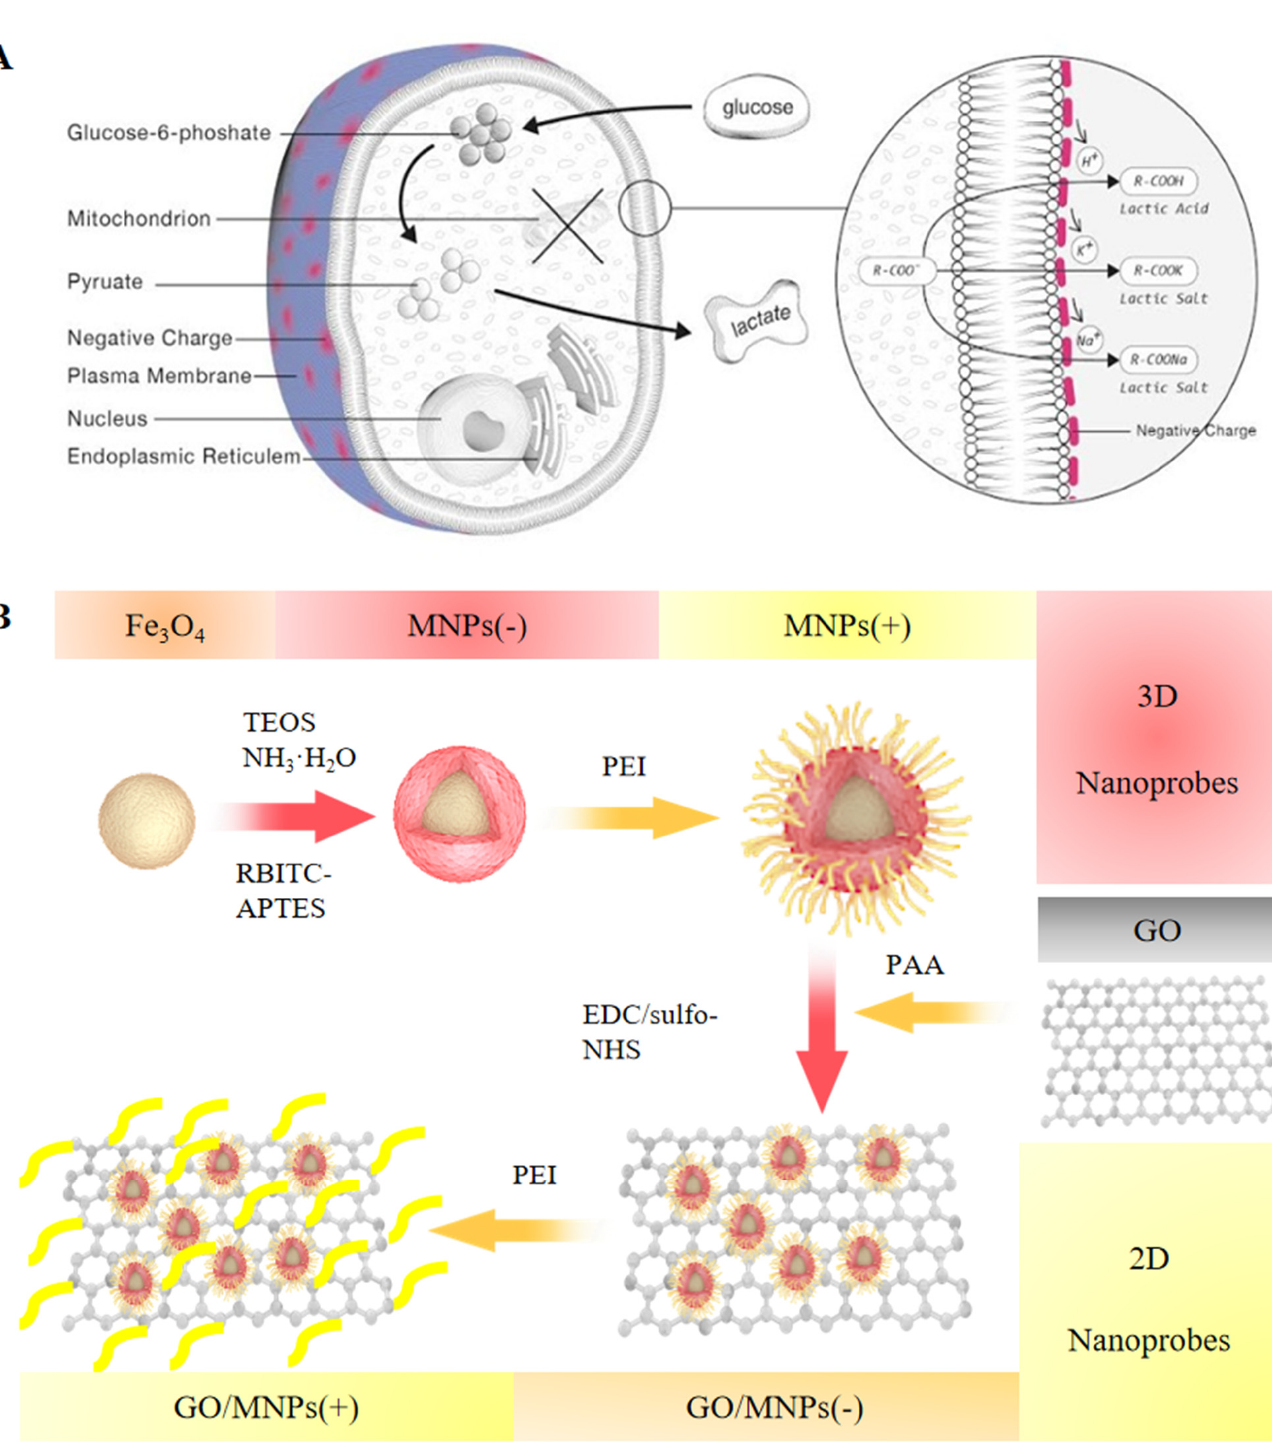
Figure 1. Design of three-dimensional (3D) and two-dimensional (2D) nanoprobes for cellular electrophysiological property detection. ( A ) Due to differences in glucose metabolic pathways, normal cells and cancer cells exhibit distinctive electrophysiological patterns. ( B ) The synthetic design of 2D and 3D nanoprobes are represented schematically. Nanoprobes with 2D are GO/MNP(+) and GO/MNP(-). Nanoprobes with 3D include MNP(+) and MNP(-). “+” indicates the nanoprobe has a positive charge, while “-” indicates a negative charge.